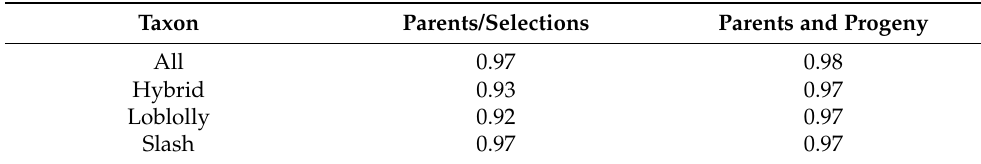
Table 4. Correlations of BLUPs estimated for all selections in the pedigree and for parents (uniquely named clones in breeding programs or suitable for commercial deployment). Correlations are calculated for all records then stratified by